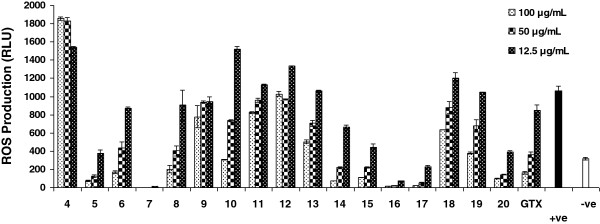
The Immunomodulatory effects of gatifloxacin (GTX) and its analog compounds on oxidative burst response using whole blood cells. Each bar represents a mean triplicate reading. +ve = Cells + Zymosan, -ve = Cells without zymosan.